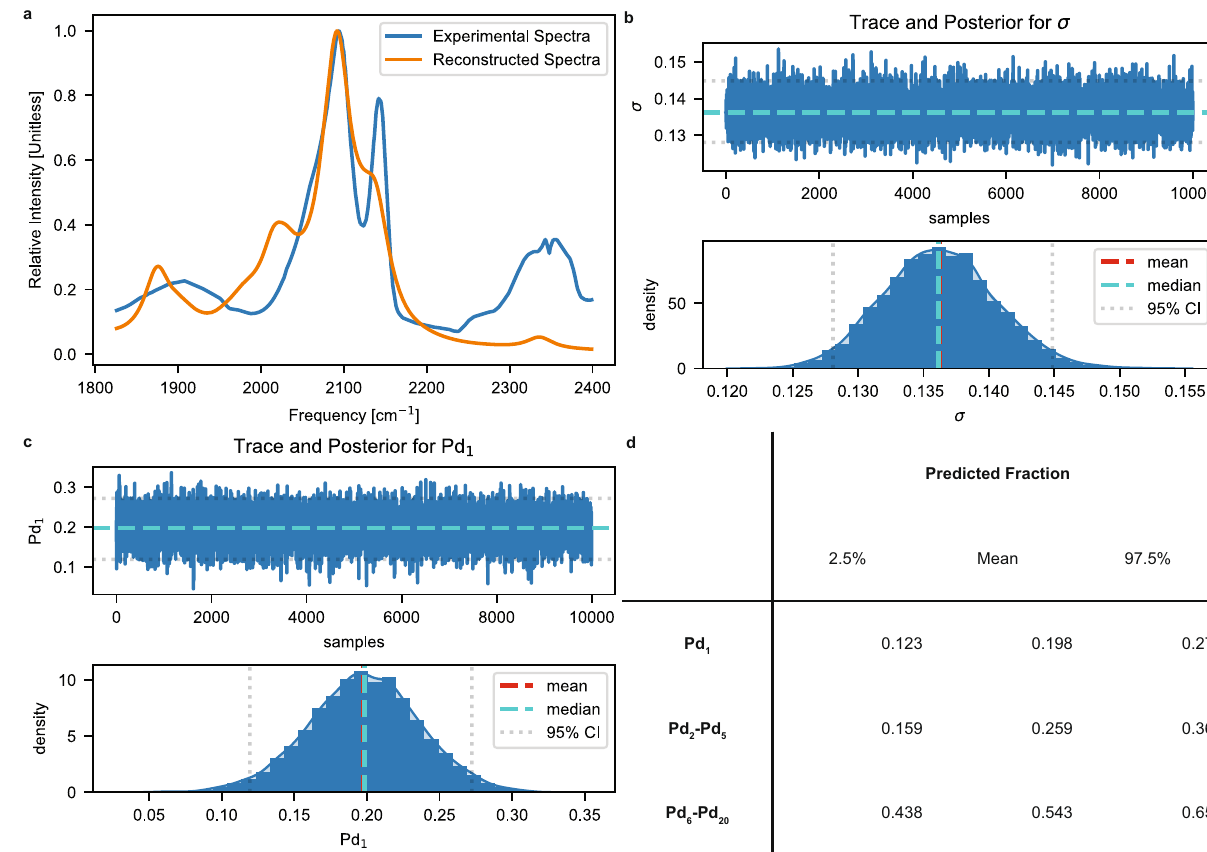
Fig.7|Experimentalspectradeconvolutionof1wt%Pd/CeO 2 systemsaturated with CO at 323K. a Discretized experimental and reconstructed spectra. Our dataset has no spectroscopic signatures above 2200cm − 1 , which agrees with Spezzati et al. ’ s heuristic assignment to CO 2 . b Trace and posterior distributionfor σ , the error parameter. The spectra are equivalent at a SNR of 60. c Trace and